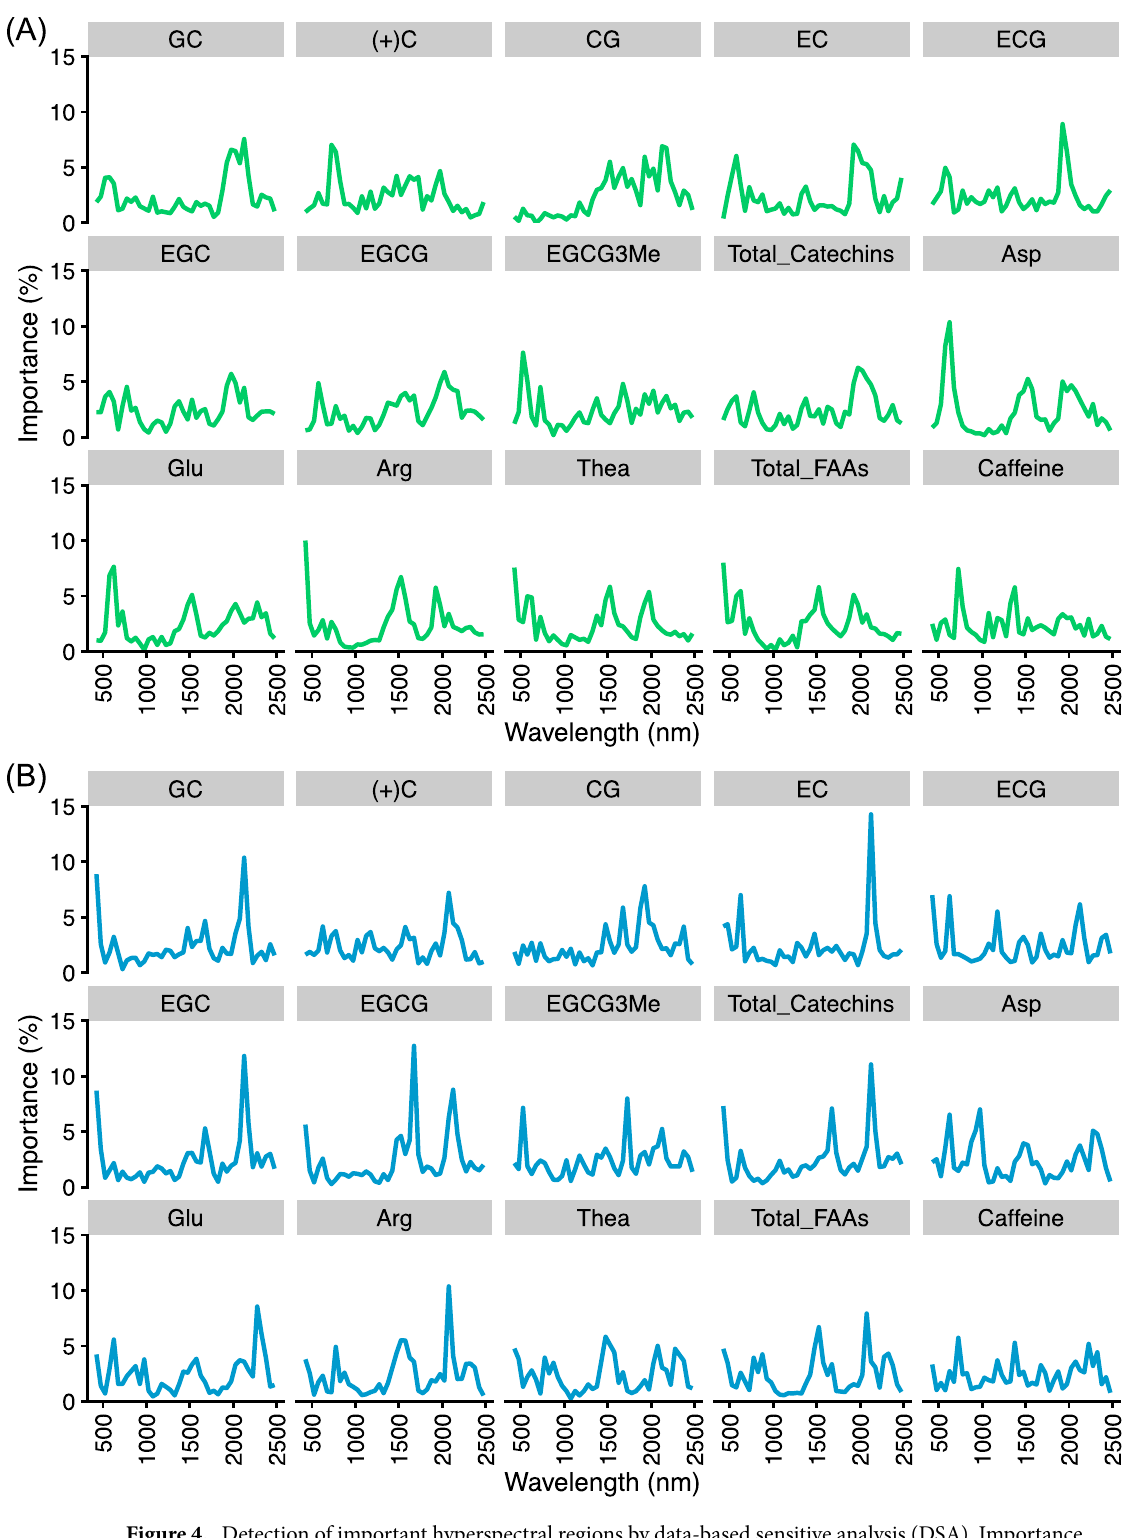
Figure 4. Detection of important hyperspectral regions by data-based sensitive analysis (DSA). Importance values, which were averaged over 100 replicates and accumulated at 50-nm intervals, were visualized as DSA results based on OR-Cubist ( A ) and DT-Cubist ( B ) treatment. Figures were visualized by the R package “ggplot2” ver.